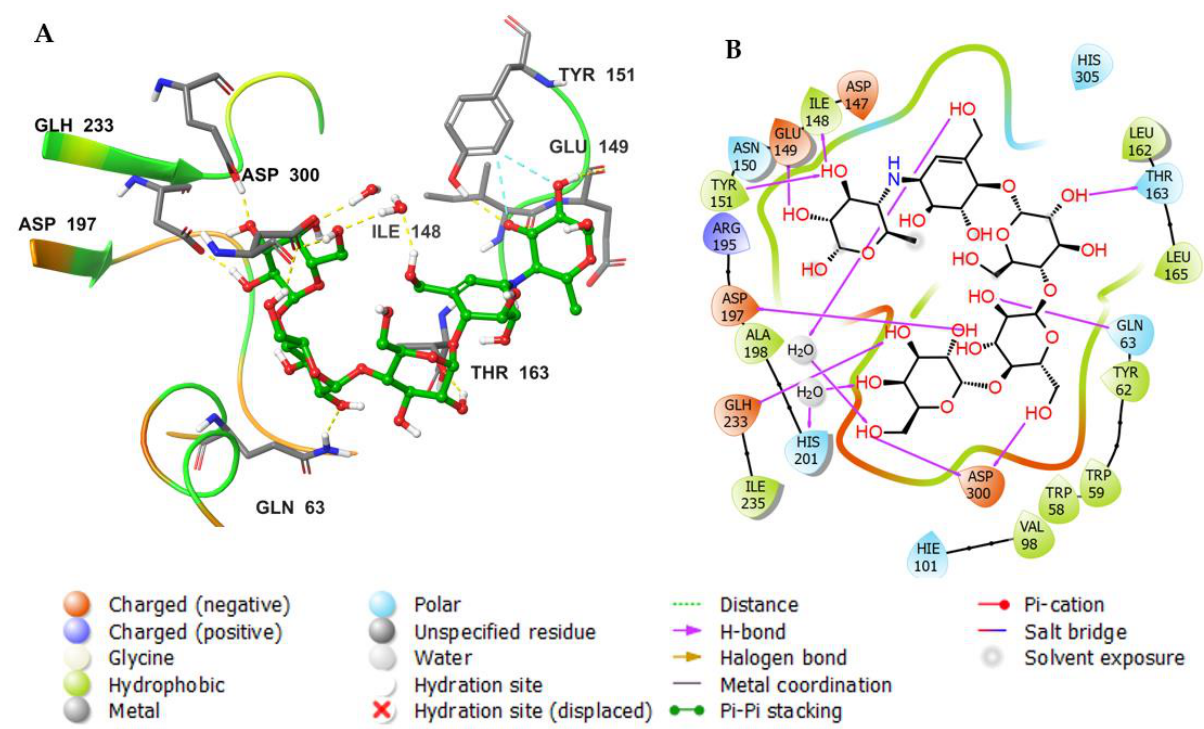
Figure 7. ( A ) Putative binding mode of acarbose in the binding site of alpha-amylase (PDB: 4GQR). The inhibitor is displayed as green sticks. The amino acid residues of the binding site are represented as thin tubes with color elements; pi-pi stacking and H-bonds are represented in cyan and yellow dotted lines, respectively. ( B ) 2D depiction of the ligand – protein interactions.